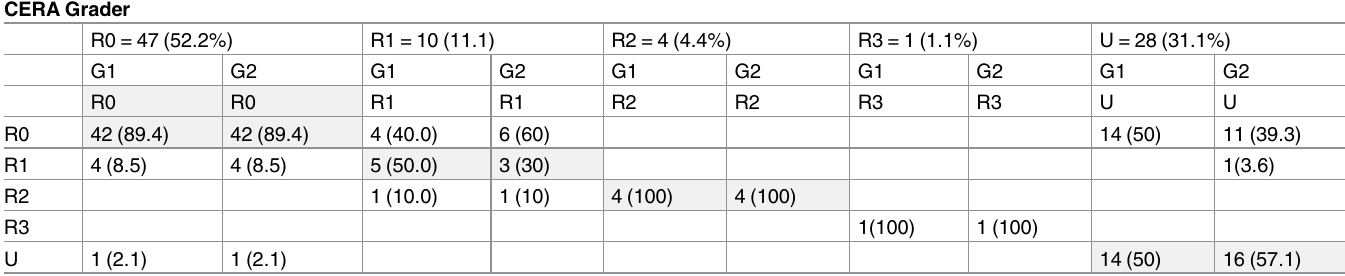
Table 3. Comparison of diabetic retinopathy graded by the CERA grader and the local graders after learning from a test set of 32 eyes graded by the CERA grader. CERA Grader R0 = 47 (52.2%)